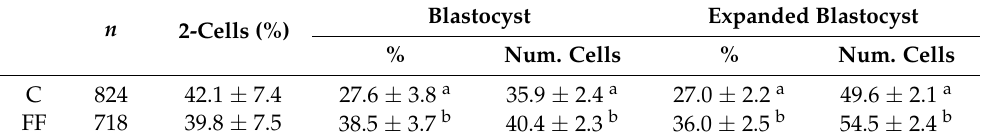
Table 4. In vitro embryo development (IVC) of putative zygotes produced by in vitro fertilization (IVF) with spermatozoa selected by follicular fluid (FF) in the chemotaxis system. IVF was performed with 25 × 10 3 selected spermatozoa/mL. After fertilization, putative zygotes continued the incubation in IVC medium (NCSU23) for up to 7 days (168 h). The percentage of embryos reaching 2-cells stage (48 h after insemination) and blastocyst and expanded blastocyst stages were analyzed (at 168 h after insemination). A group in which the spermatozoa were selected without chemoattractant was used as the control (C). Embryos after 7 days of culture were fixed with glutaraldehyde and stained with bisbenzimide solution. Evaluation was carried out by fluorescence microscopy. As an indicator of embryo quality, the number of cells forming each blastocyst was determined. Six replicates were performed. Blastocyst Expanded Blastocyst n 2-Cells (%) % Num. Cells % Num. Cells C 824 42.1 ± 7.4 27.6 ± 3.8 a 35.9 ± 2.4 a 27.0 ± 2.2 a 49.6 ± 2.1 a FF 718 39.8 ± 7.5 38.5 ± 3.7 b 40.4 ± 2.3 b 36.0 ± 2.5 b 54.5 ± 2.4 b 2-cells (%): percentage of oocytes that cleaved to the 2-cell stage of embryo development were evaluated at 48 h after insemination. Blastocyst and expanded blastocysts: percentage of 2-cells embryos that developed to blastocyst or expanded blastocyst stage (according to the classification proposed by B ó and Mapleroft, [26]) after 7 days (168 h) of culture. The number of cells were determined by fluorescence microscopy in blastocyst and expanded blastocysts fixed in 0.5% glutaraldehyde and stained with bisbenzimide solution. One-way ANOVA was performed and the Tukey test of multiple comparisons. Results are expressed as the mean ± SEM. The different superscripts ( a–b ) within the same column indicate the significant differences between groups ( p <